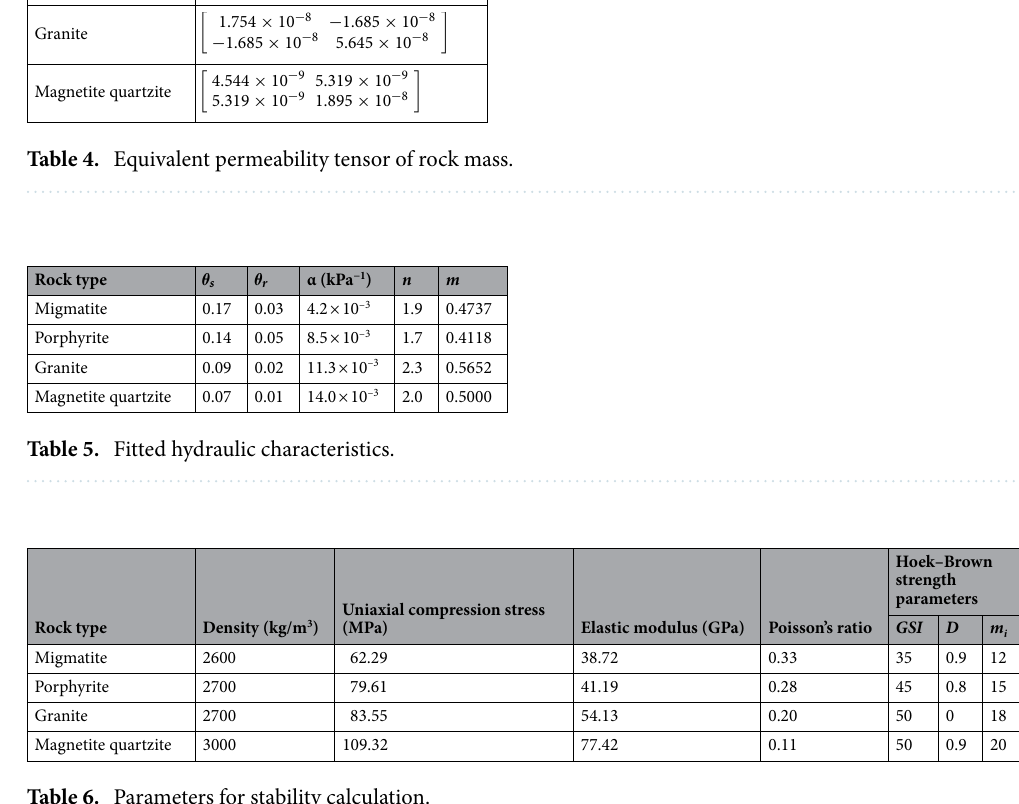
Table 6. Parameters for stability